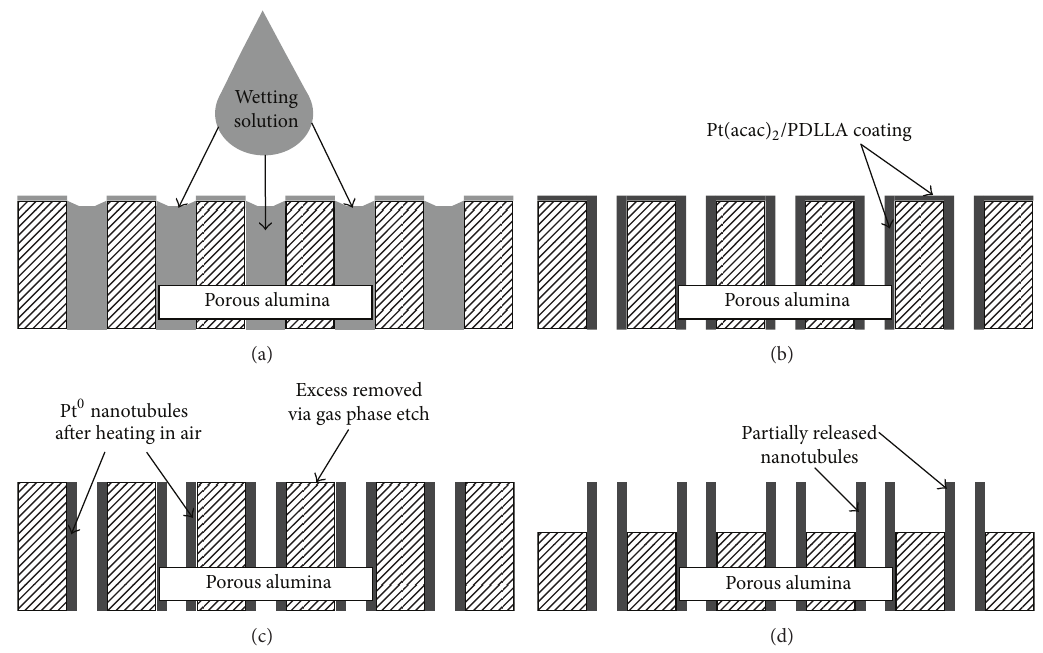
Figure1:Overviewofthetemplatewettingnanofabricationprocessformakingaplatinumnanotubulearray.(a)Aporousaluminatemplateis wetted with a solution of Pt(acac) 2 and PDLLA in chloroform. (b) After evaporation of the solvent, a solid Pt(acac) 2 /PDLLA coating remains on the pore walls of the template. (c) A helium plasma etch is used to remove excess material on the outer surfaces, after which samples are annealed in air to reduce the Pt(acac) 2 to Pt 0 as well as to oxidize and remove the PDLLA. (d) The resulting Pt nanotubes were partially released by selectively etching the alumina template in 25 wt.% KOH(aq) for